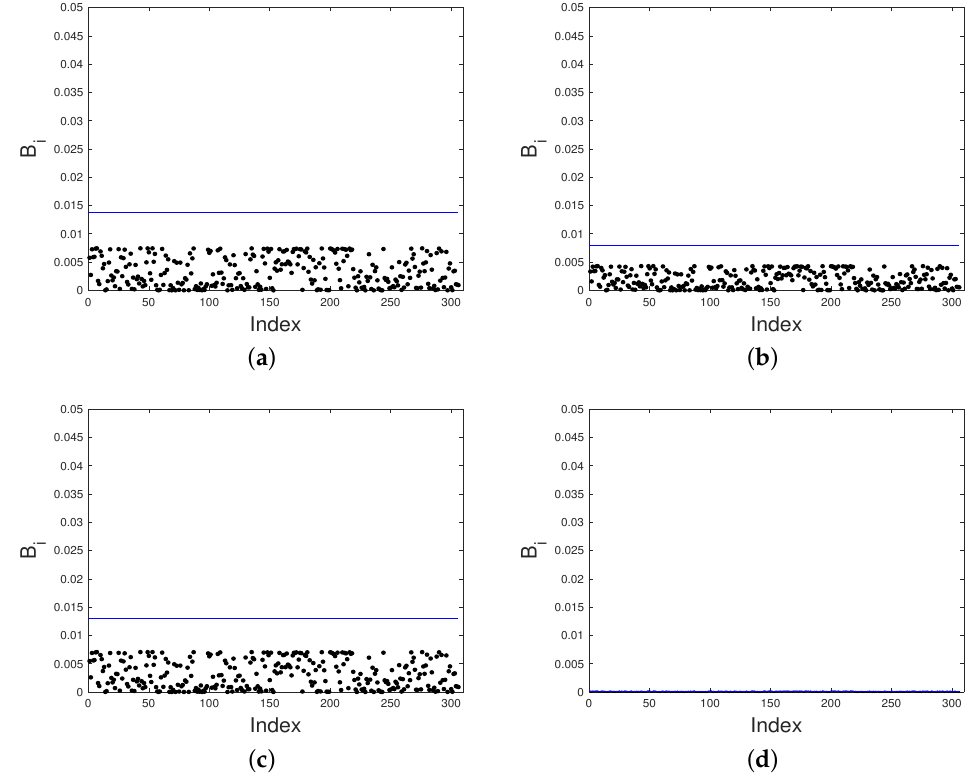
Figure 16. Index plots of B i for assessing local influence on (cid:98) α ( a ); (cid:98) β 1 ( b ); (cid:98) β 2 ( c ); and (cid:98) φ ( d ) under explanatory variable perturbation for Student-t PVCM (Lima